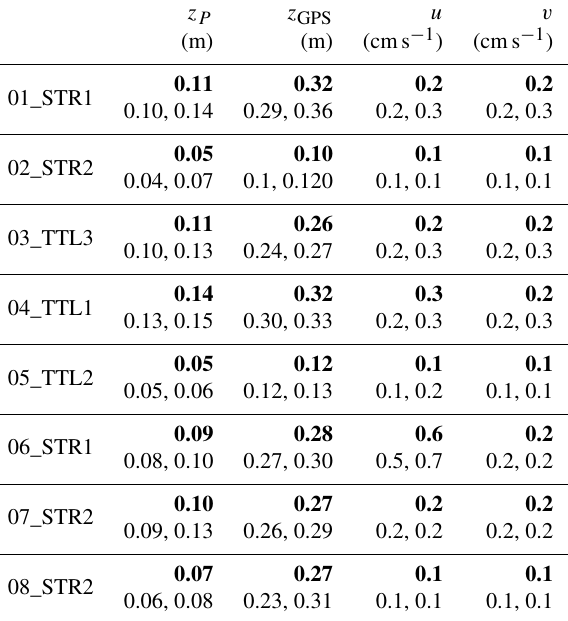
Table 3. Same as Table 2 but for altitudes derived from the pressure and altitude observations as well as zonal and meridional